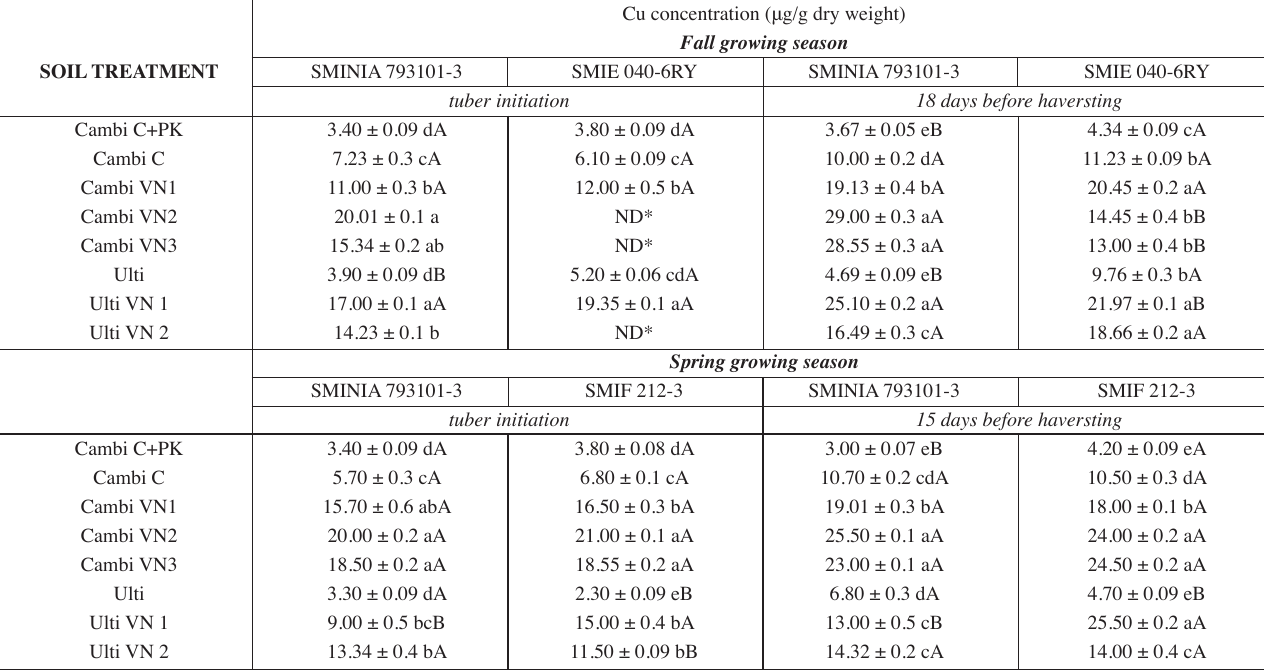
Data represent the mean ± S.D. of six different replicates. Different lowercase letters indicate significant differences between Cu levels in the same potato genotype and collect (p < 0.05). Different capital letters indicate significant differences between potato genotypes at the same Cu level and collect (p < 0.05) ND* (data not available).